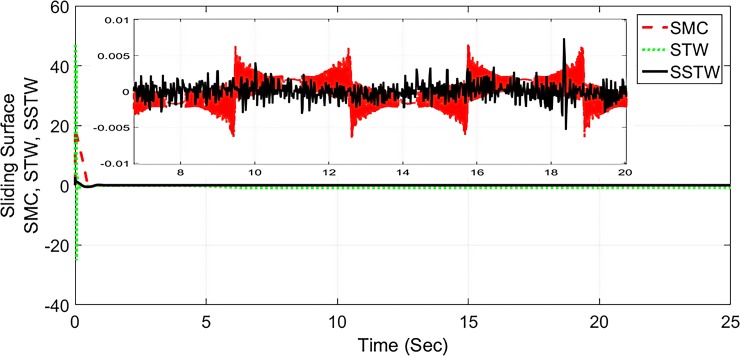
Sliding manifold convergence profile of SMC, STW and SSTW, rd = 22cm.